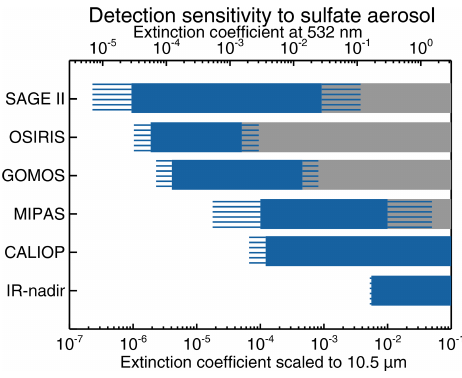
Figure 15. Detection sensitivity to sulfate aerosol extinctions for different satellite-based instruments. The blue bars indicate a con- servative estimate of detectable extinctions given in Table 1 and scaled to 950cm − 1 . The grey bars indicate detectable but optically thick extinctions. The blue stripes indicate the uncertainties due to the scaling factor for SAGE II and IR nadir. For MIPAS, CALIOP, GOMOS, and OSIRIS the blue stripes are a combination of un- certainties due to the scaling factor and less conservative detection thresholds (lower minimum extinctions) given in the literature. For CALIOP only the nighttime extinctions are considered. Further de- tails on the instruments’ measurement capabilities and the corre- sponding references are given in Table